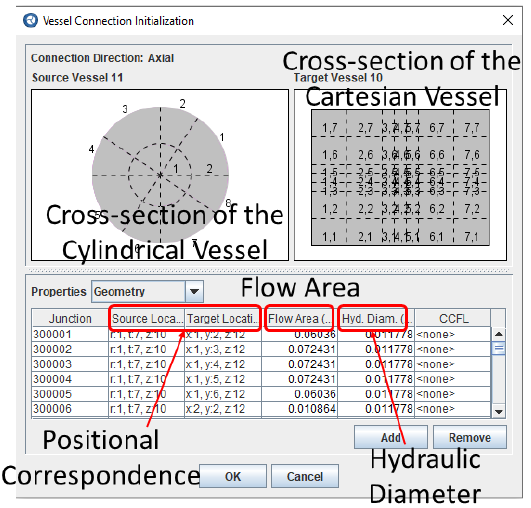
Figure 4. The definition panel of VJ components in SNAP.